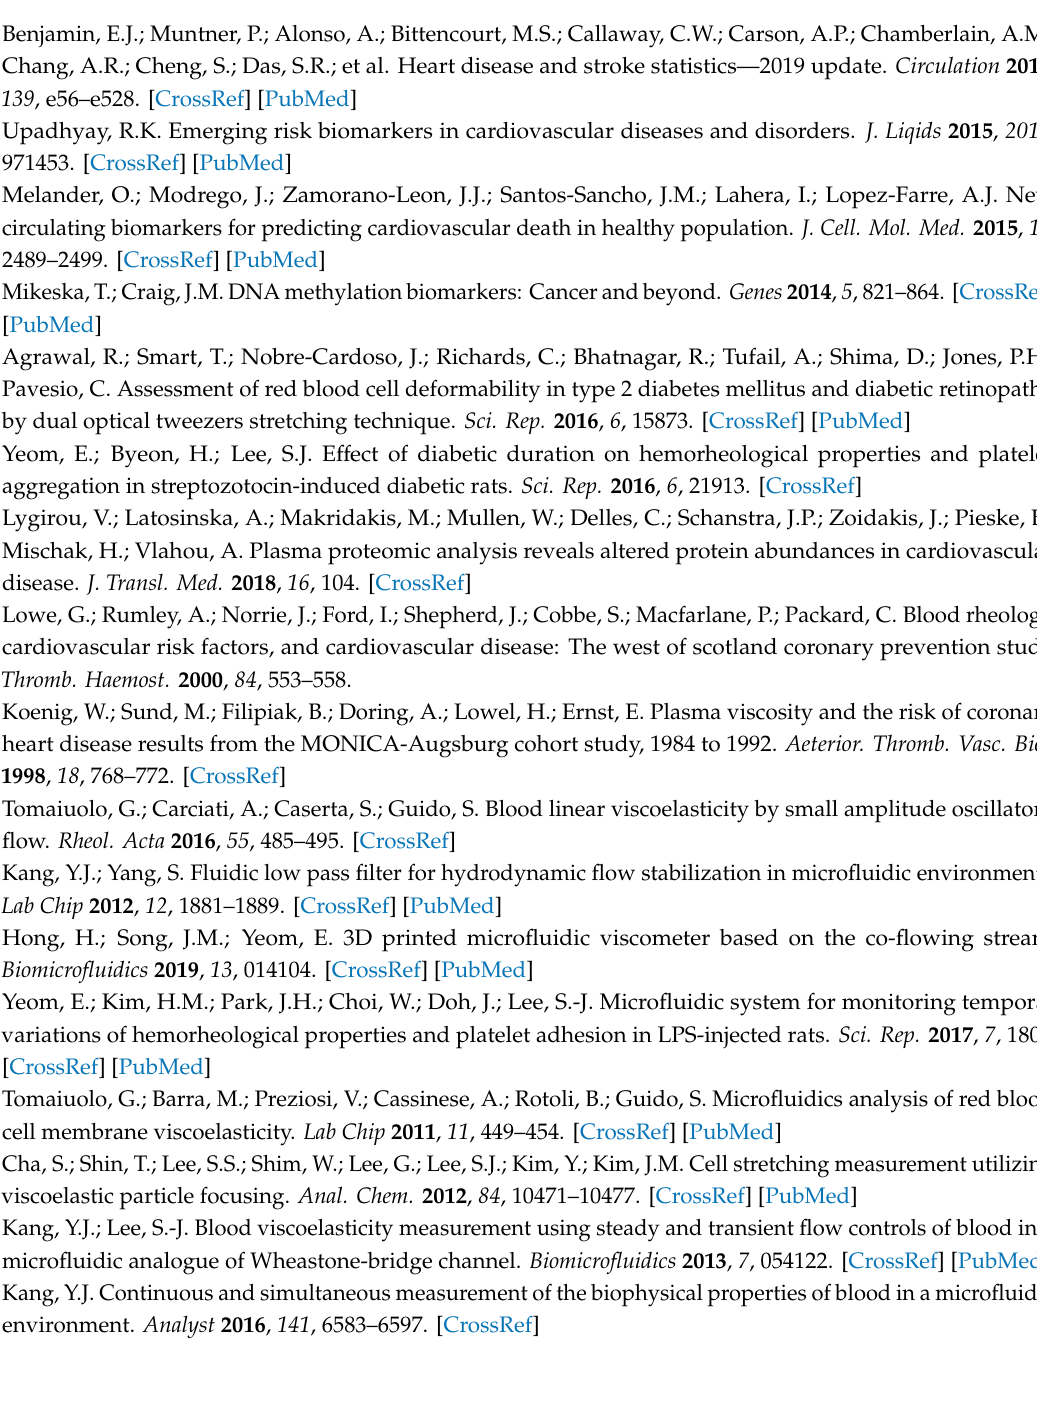
Figure S1: Mask drawing of silicon